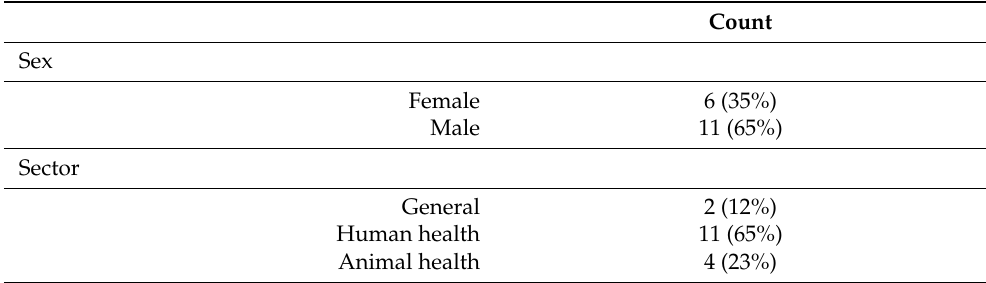
Table 2. Sociodemographic description of all